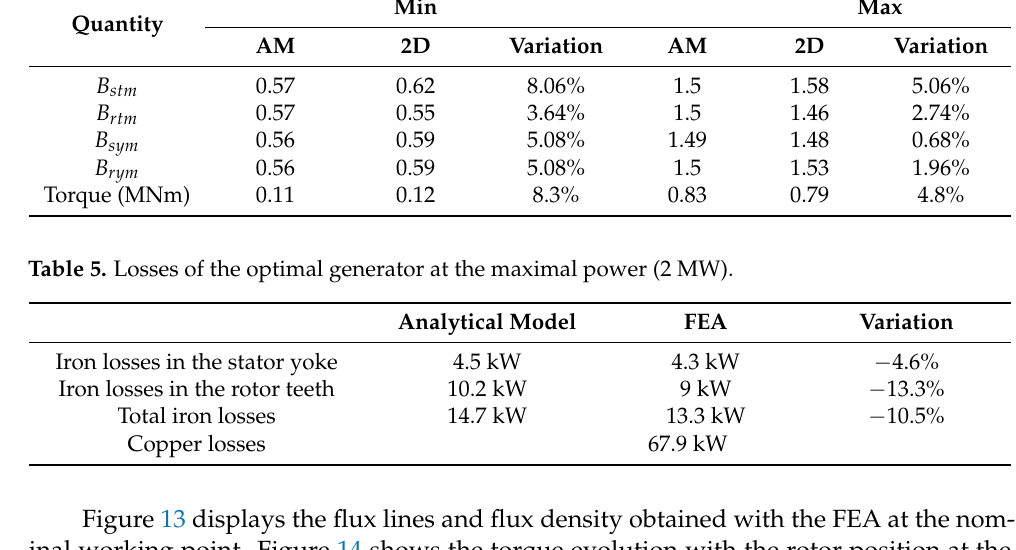
T Figure 14. Torque evolution with rotor position at full power obtained by the FEA.